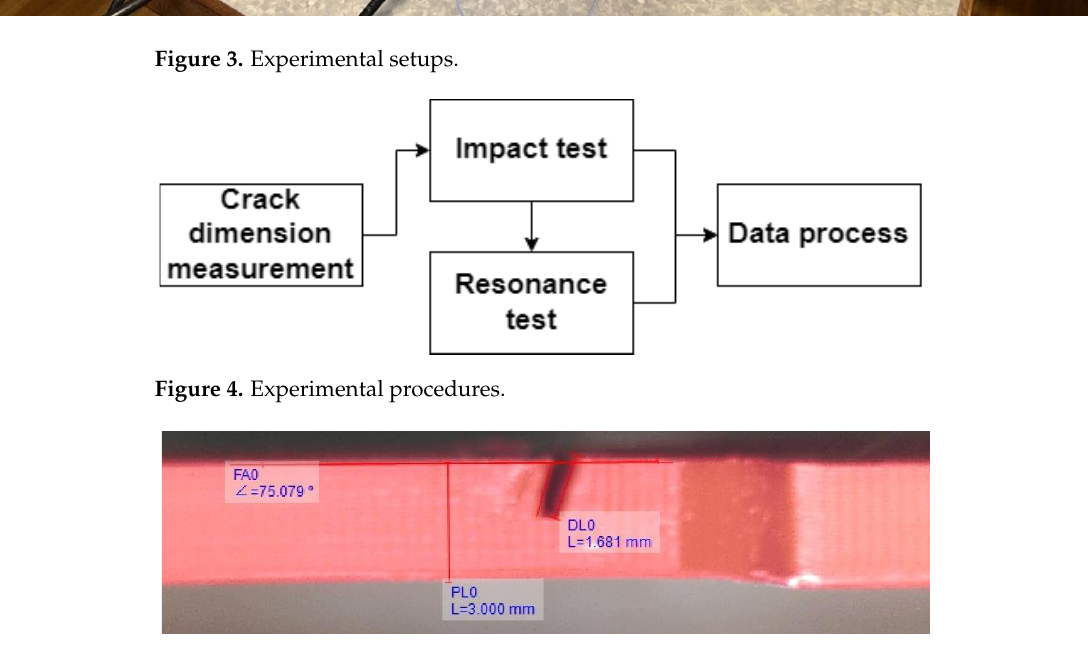
Figure 3. Experimental setups.